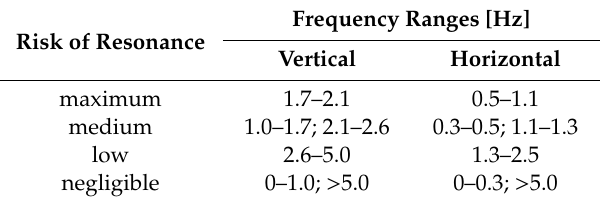
Table 1. The resonance risk levels and corresponding ranges of natural frequencies [21].